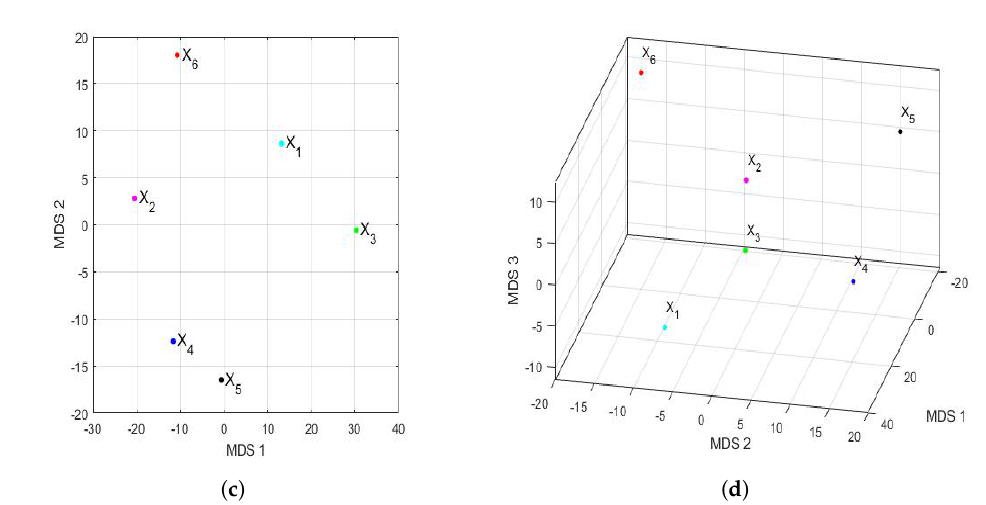
Figure 18. First two and three principal coordinates of the feature vectors by semesters of each of the years of the 2015–2020 six-year term: X 1 (2015), . . ., X 6 (2020). ( a ) Feature vectors: first 2 principal coordinates of the first semester. ( b ) Feature vectors: first 3 principal coordinates of the first